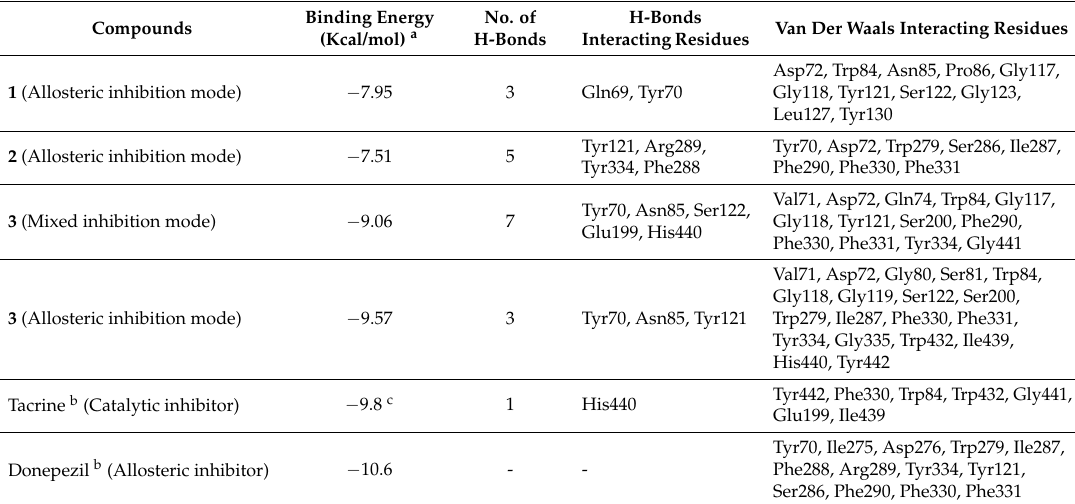
Table 2. Docking affinity scores and possible H-bond formation to AChE (1acj) active sites by 1 , 2 , and 3 along with reported